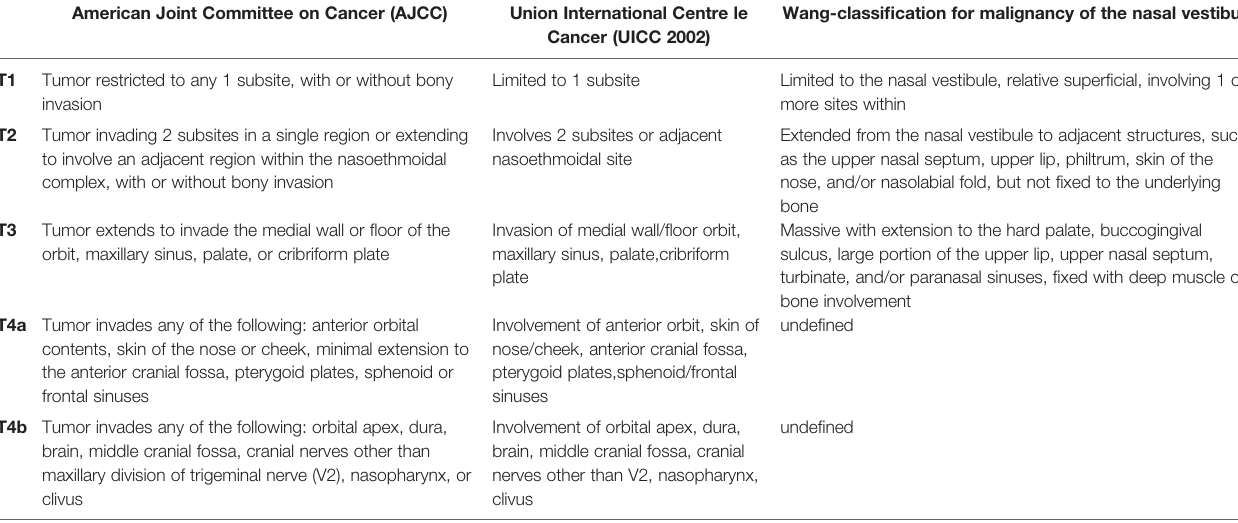
TABLE 1 | Classi fi cation systems for malignancies of the nasal cavity/paranasal sinuses and the nasal vestibule. American Joint Committee on Cancer